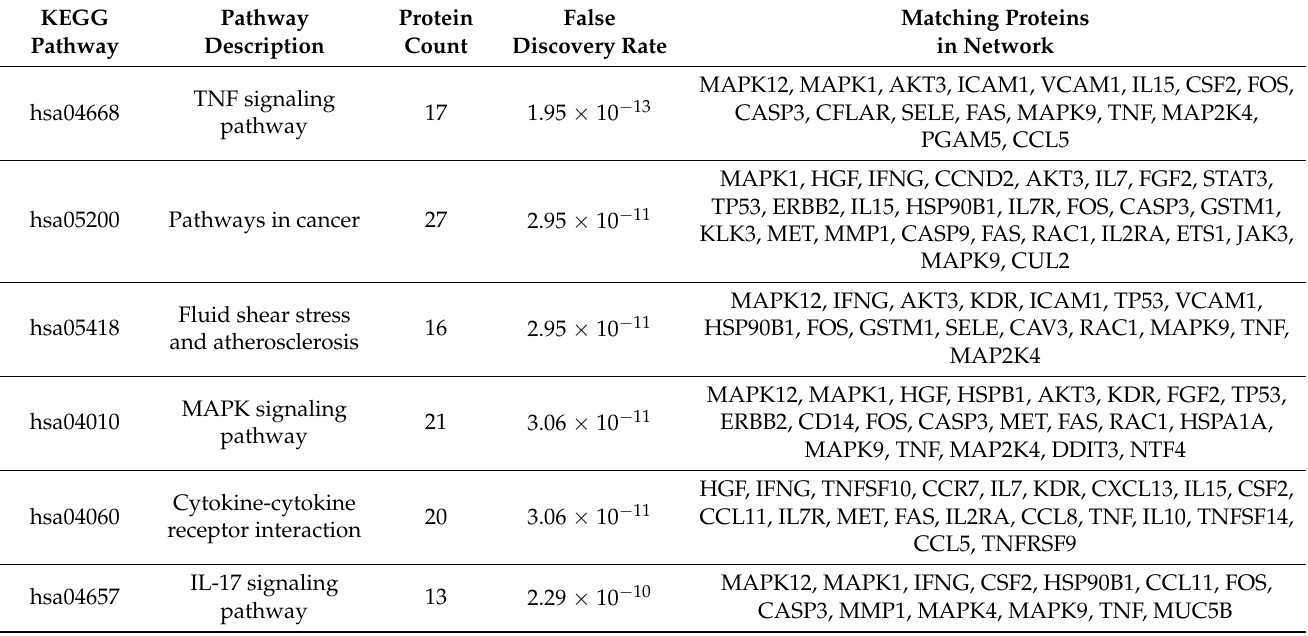
Table 3. Significantly impacted signaling pathways in hTCEpi cells after AC EF stimulation based on the antibody microarray